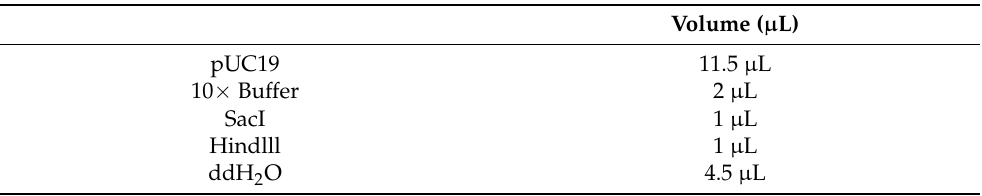
Table 3. Enzyme digestion